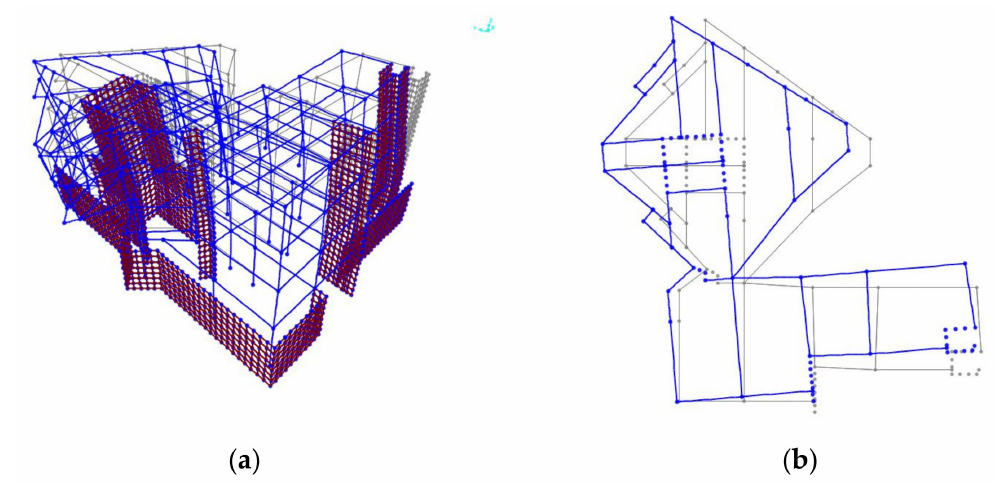
Figure 17. Second mode is a torsional-bending mode along x axis with frequency equal to 7.67 Hz (in grey the un-deformed configuration and in blue the mode shape): ( a ) 3D view; ( b ) plan view.